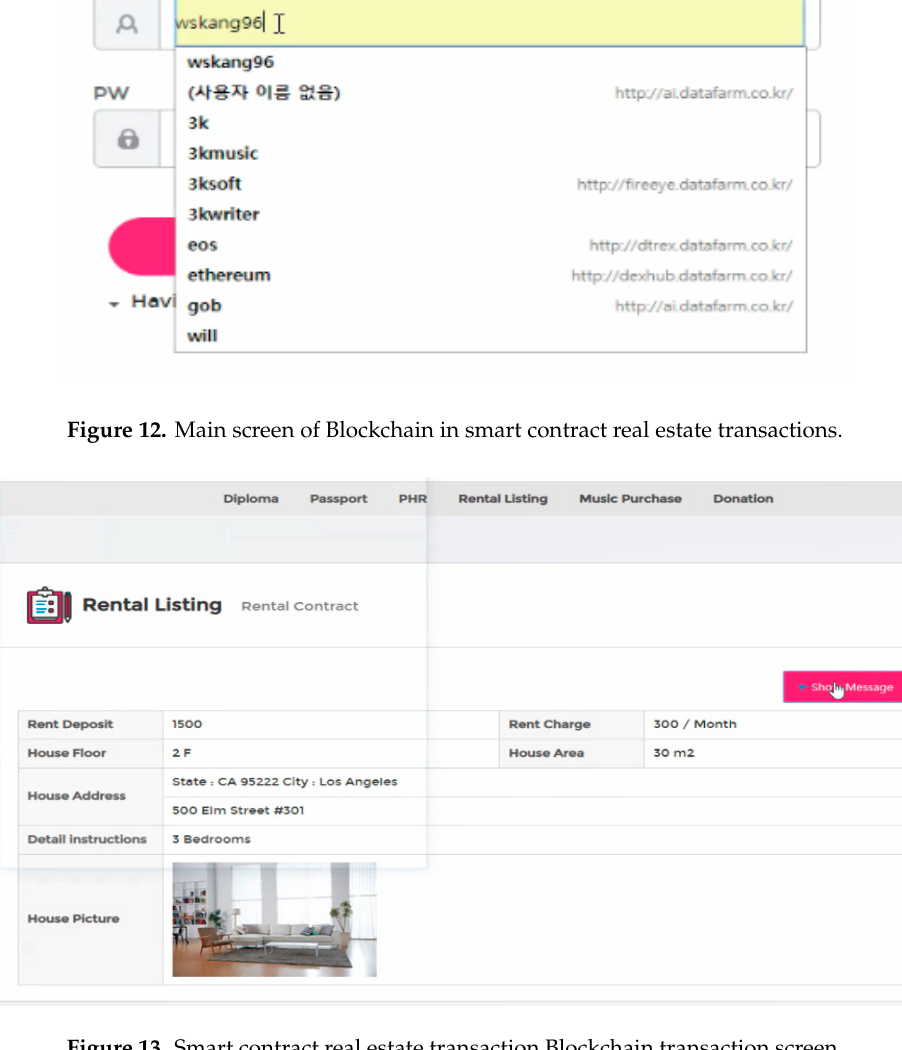
Figure 13. Smart contract real estate transaction Blockchain transaction screen.